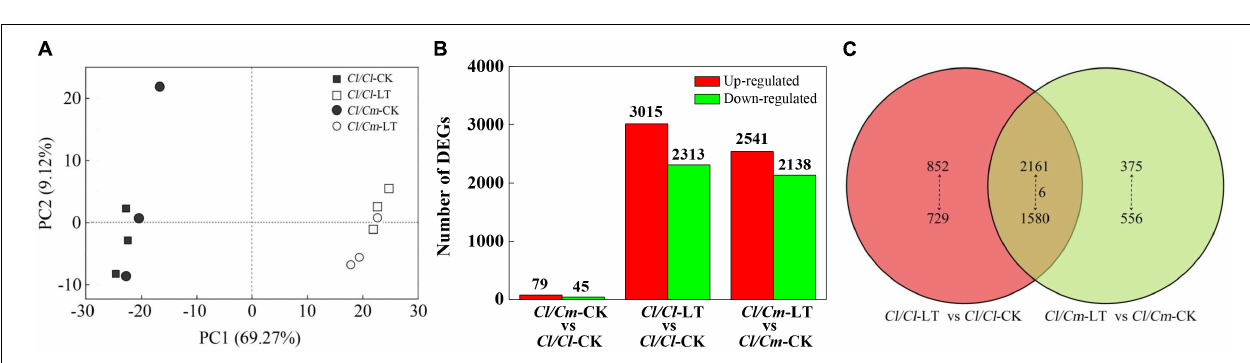
FIGURE 5 | Global transcriptome responses of grafted plants to chilling stress. (A) Principal component analysis (PCA) showing the divergence of the respective transcriptomes in response to chilling stress. (B) Number of DEGs under different treatments. (C) Venn diagrams showing the overlap among DEGs in each